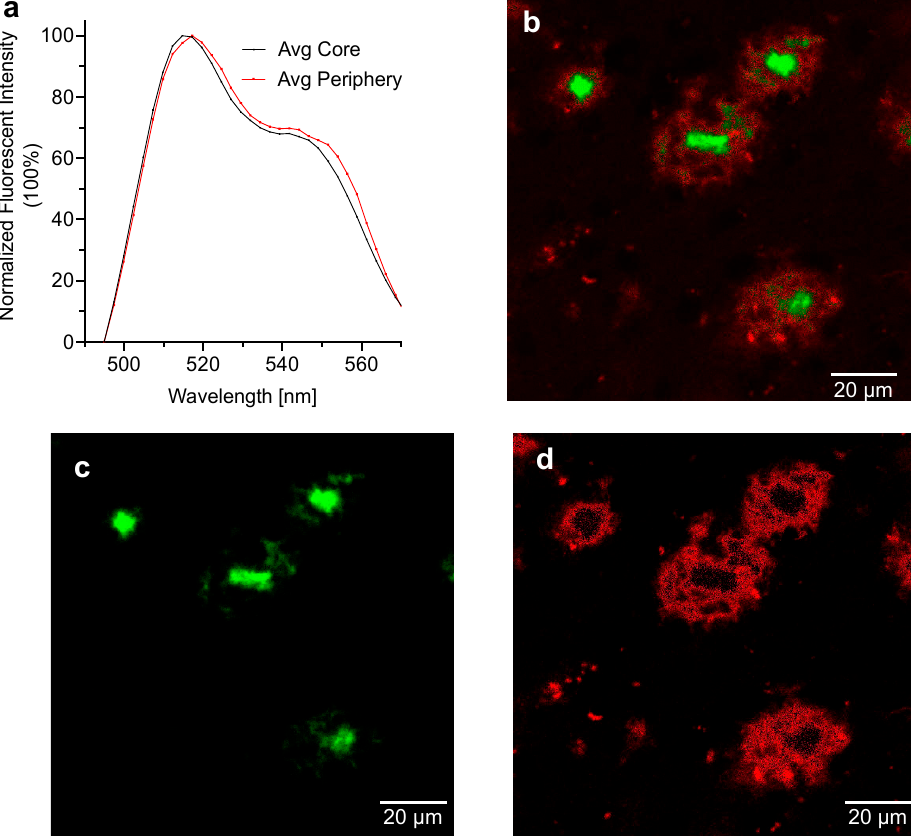
Figure 3. ( a ) Emission spectra peaks from 5× FAD transgenic mouse brain sections stained with CRANAD-28; ( b ) Merged confocal microscope images A β plaques from the unmixed image of core (green) and the unmixed image of periphery (red). 488 nm excitation, 40× objective, zoom 2×; ( c ) confocal microscope image of the unmixed core component using the extracted spectra; and ( d ) confocal microscope image of the unmixed periphery component using the extracted spectra.